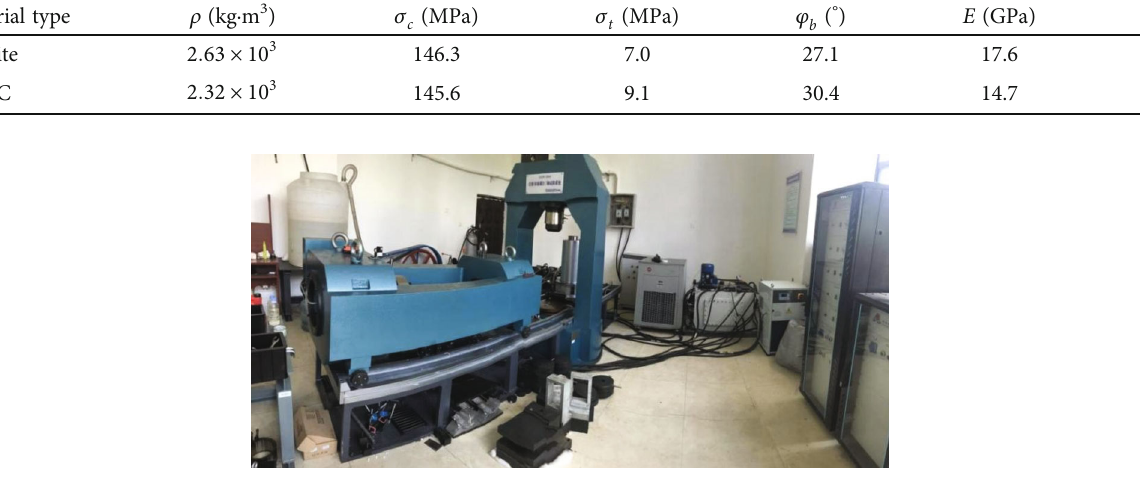
Figure 2: Rock joint shear- fl ow coupling test